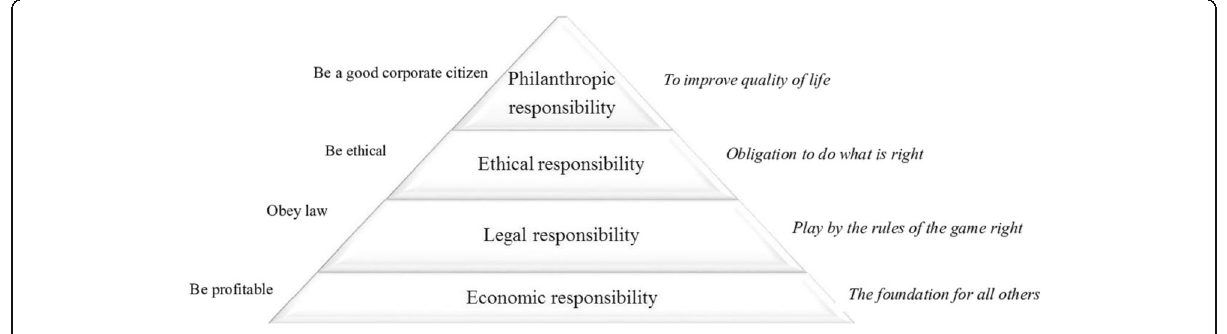
Fig. 3 Pyramid model of CSR. Source: Carroll (1991,